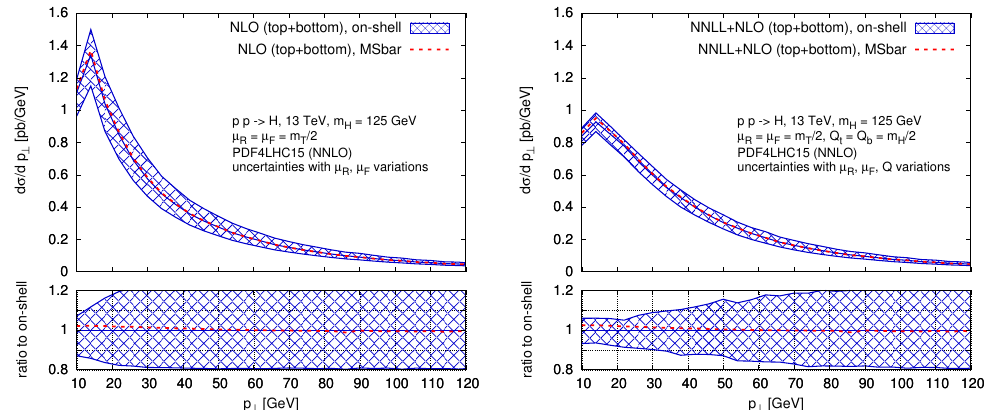
Figure 6 . The full top plus bottom distribution for the (cid:12)xed order (left) and the matched (right) results, for di(cid:11)erent choices of the mass renormalization scheme. See text for details. mass-renormalization scheme and the central value for the MS scheme. The uncertainty band is calculated from a 7-point scale variation. We see that the scheme ambiguity is larger than the scale variation, as already observed in ref. [36]. The right plot shows our results for the matched distributions with the two di(cid:11)erent mass schemes. The di(cid:11)erence between the two bottom-mass schemes is similar to the (cid:12)xed order case, but since now the matched prediction has a smaller uncertainty, the separation between the two results is more signi(cid:12)cant. As follows from (cid:12)gure 5, the top-bottom interference contribution has an ambiguity of about 15 (cid:0) 20% down to p (cid:24) 10 GeV. In order to improve on this, one would ? need a NNLO calculation for the top-bottom interference, which is currently out of reach. The analogous plots for the full distribution that includes both top and bottom ampli- tudes are shown in (cid:12)gure 6, for the (cid:12)xed order (left) and resummed (right) results. Unlike for the top-bottom interference contribution, in this case the di(cid:11)erence between the two results for the bottom-mass schemes are much smaller, at the level of a few percent. This is because the top-bottom interference contributes to just O ( (cid:0) 5%) of the full spectrum. 15 Our best current predictions for the top-bottom interference and full p spectrum ? including all the relevant uncertainties are shown in (cid:12)gure 7. As discussed earlier, the uncertainty bands are obtained as an envelope of: